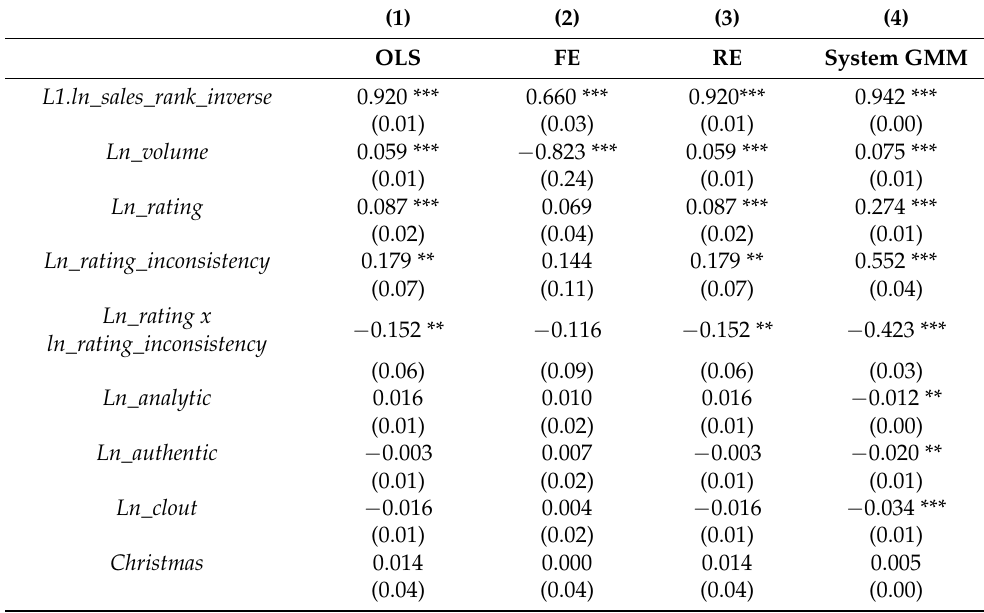
Table A4. Most helpful visibility—five most recent reviews are viewed (case v 3.2